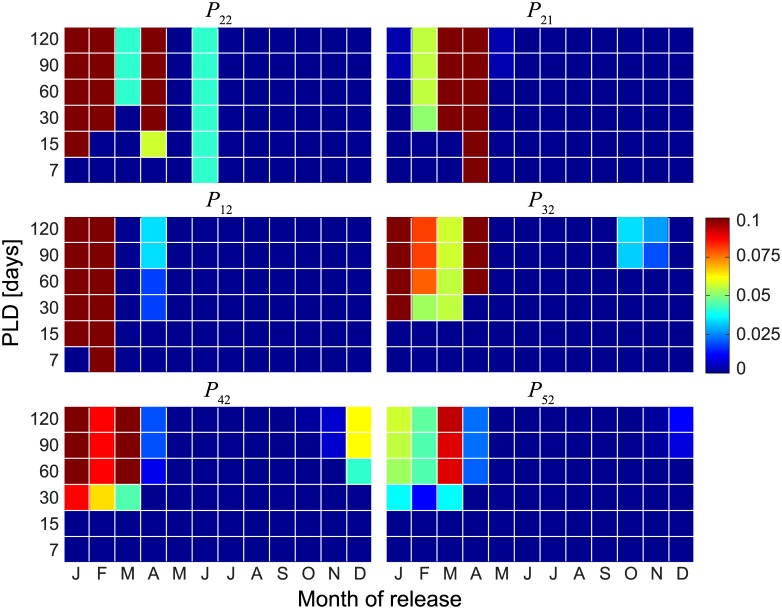
Connectivities for Palmyra Atoll.Self- (P22), out- (P2j) and in-bound (Pi2) connectivity for Palmyra Atoll as a function of spawning season and PLD. Results refer to year 2000 and are obtained for β = 10 km. Connectivity patterns to Washington, Fanning and Christmas Islands are not shown because connectivity scores are less than 1% for every combination of PLD and release season.